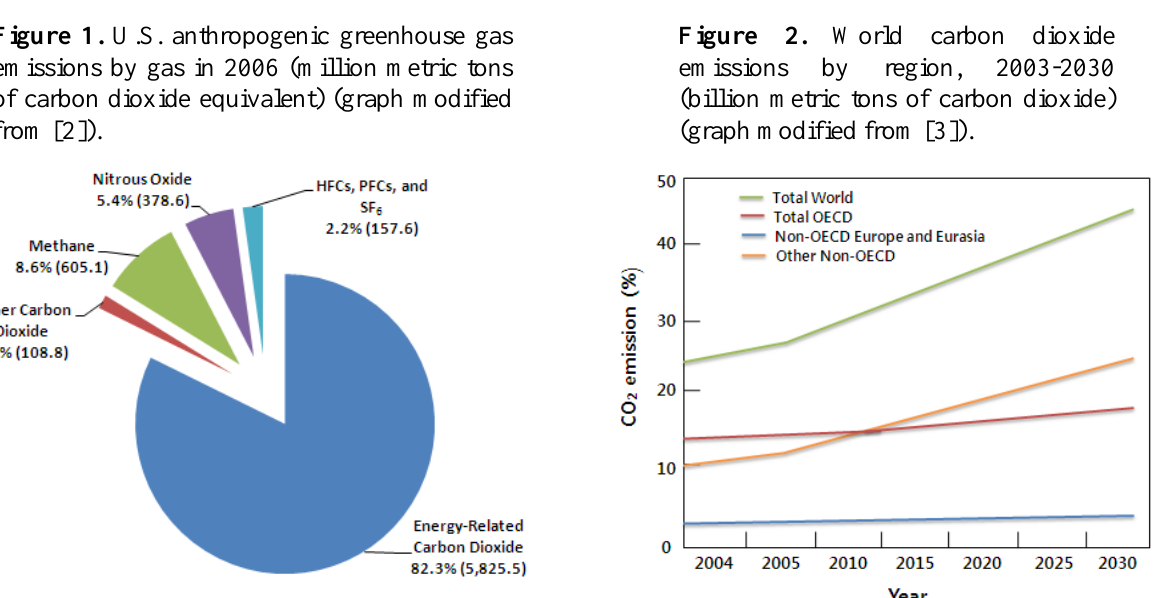
Figure 2. World carbon dioxide emissions by region, 2003-2030 (billion metric tons of carbon dioxide) (graph modified from